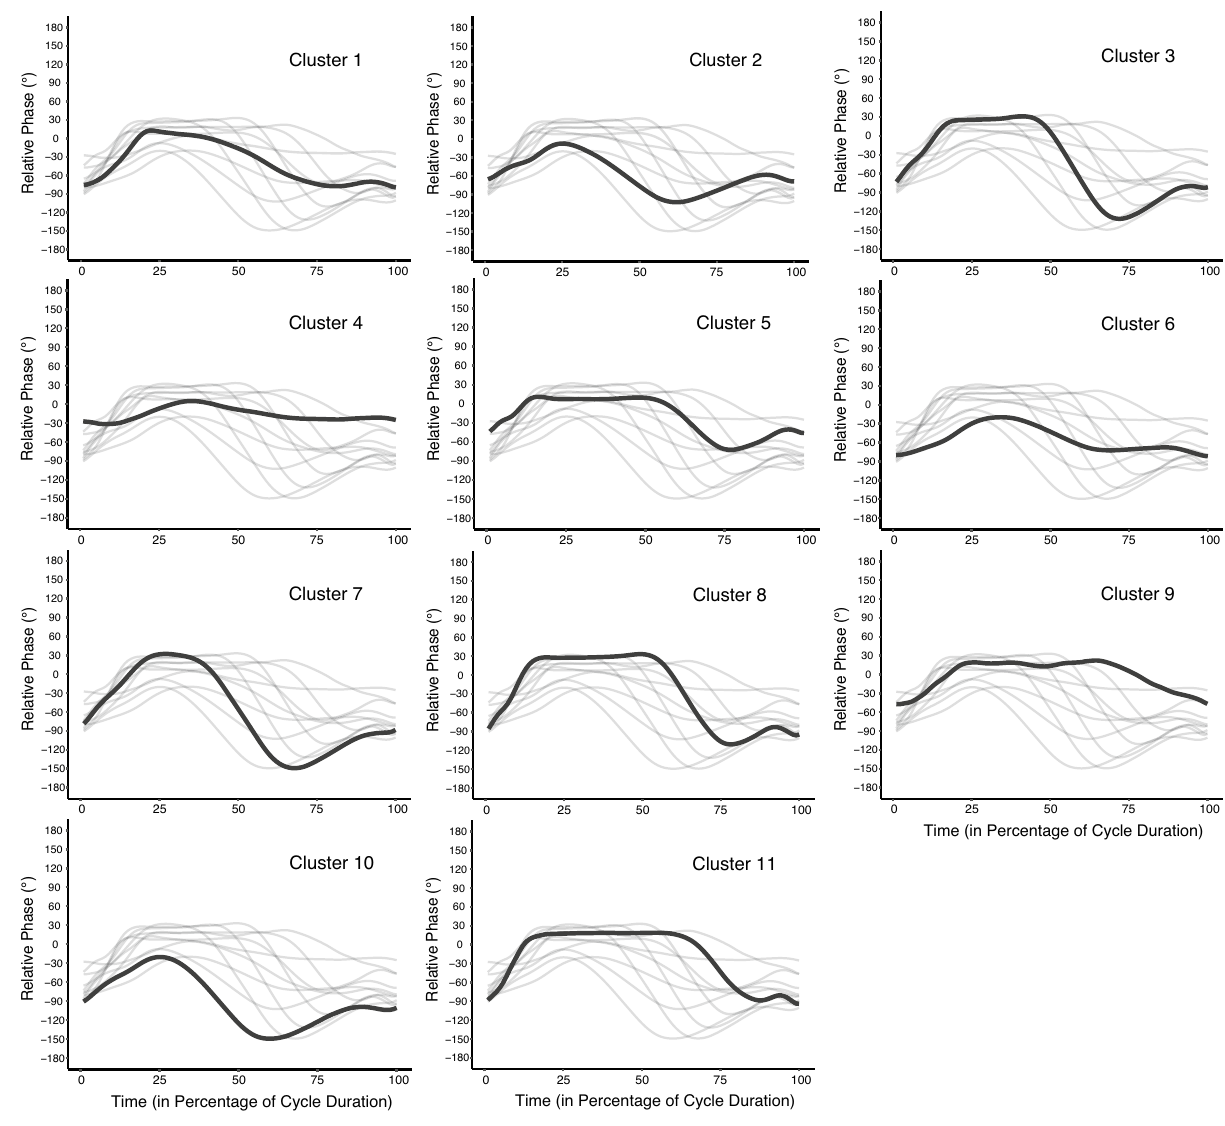
Figure 2. Coordination profiles. Average coordination patterns for each of the 11 emerging clusters (the grey backgrounds represent the 10 other profiles as